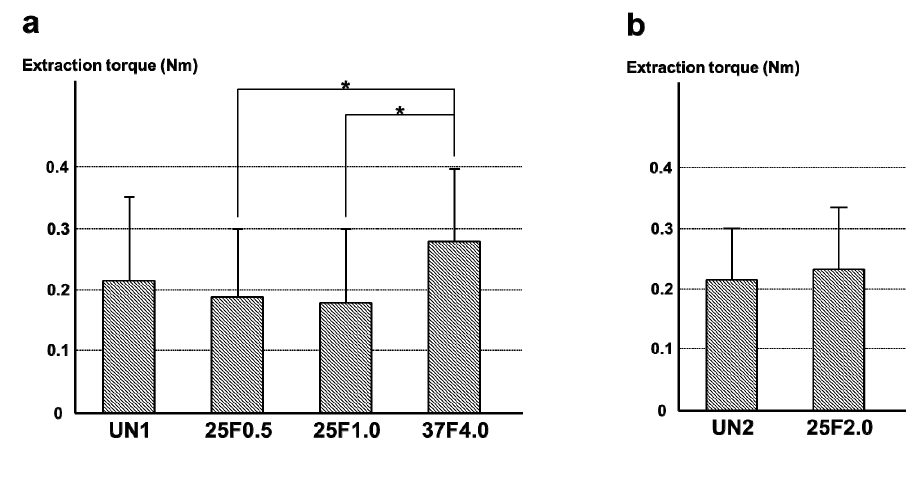
Figure 14. Average values of extraction torque for ( a ) the UN1, 25F0.5, 25F1.0, and 37F4.0 groups; ( b ) the UN2 and 25F2.0 groups. * p <